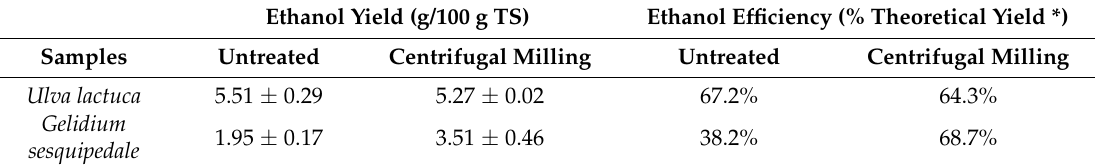
Table 4. Ethanol yield (g/100 g TS) obtained after 72 h of SSF of untreated and milled algae with an enzyme dosage of 10